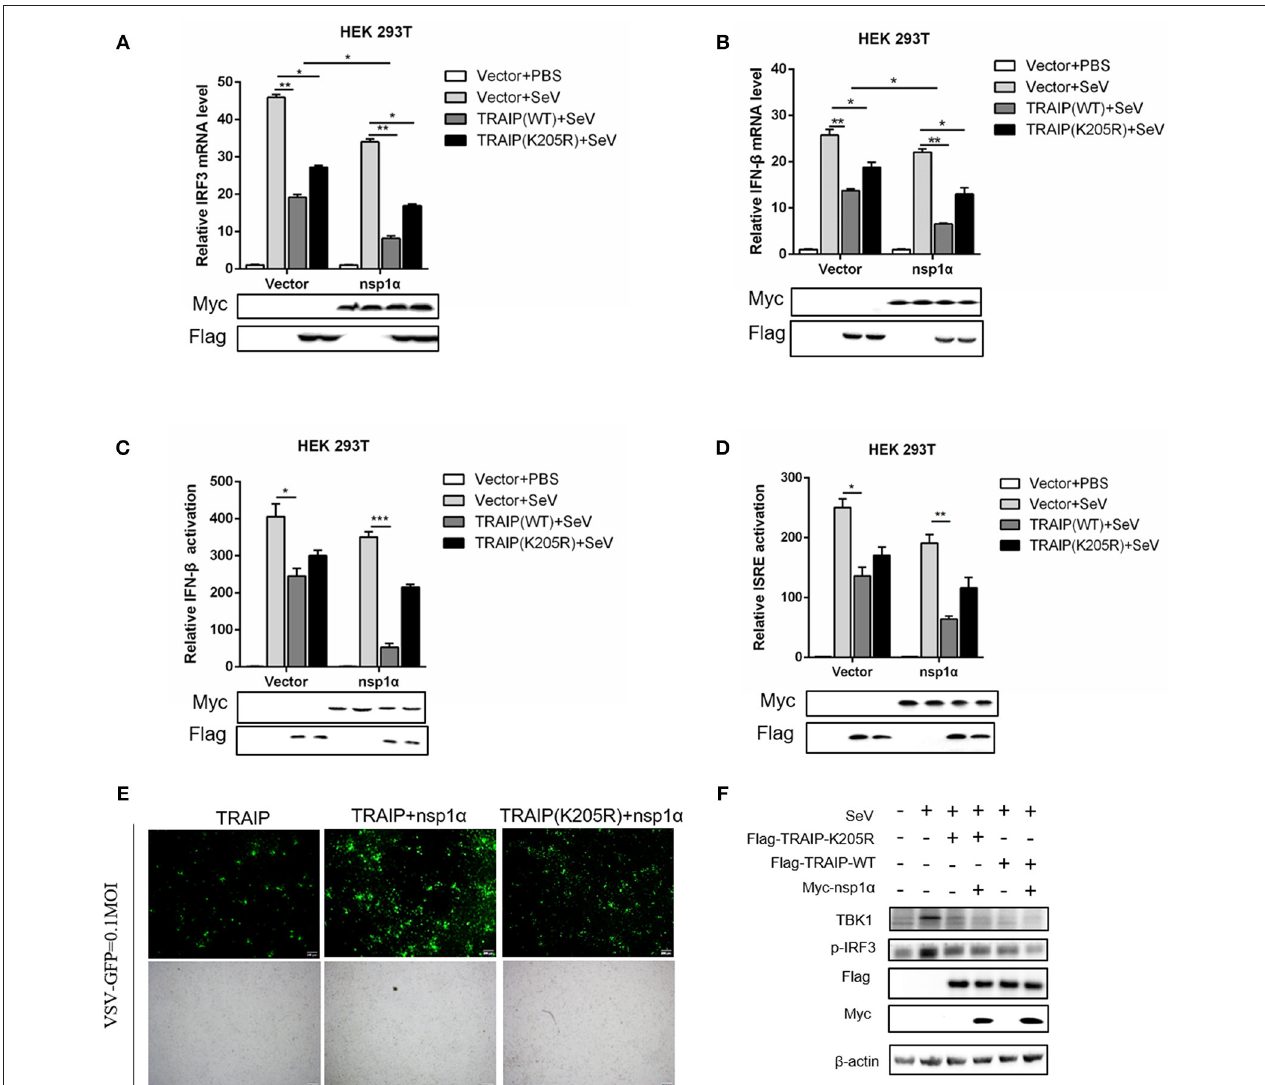
FIGURE 10 | The inhibitory effect of TRAIP and nsp1 α on interferon-mediated innate immunity. (A,B) HEK293T were transfected with TRAIP or TRAIP(K205R)together with Myc-nsp1 α or Myc-empty vector respectively and then infected with 0.1 MOI SeV for 12h. Cells were harvested, mRNA expression of IRF3 (A) and IFN- β (B) were analyzed by qRT-PCR, and TBK1 and p-IRF3 were detected by Western blotting (F) . (C,D) HEK293T were transfected with TRAIP or TRAIP(K205R)and Myc-nsp1 α or Myc-empty vector together with IFN- β reporter or ISRE reporter constructs for 18h and then infected with 0.1 MOI SeV before being lysed for luciferase assays. (E) HEK293T were transfected with TRAIP or TRAIP(K205R)together with Myc-nsp1 α or Myc-empty vector and then infected with 0.1 MOI VSV-GFP, immunofluorescence microscopy imaging detected the proliferation of